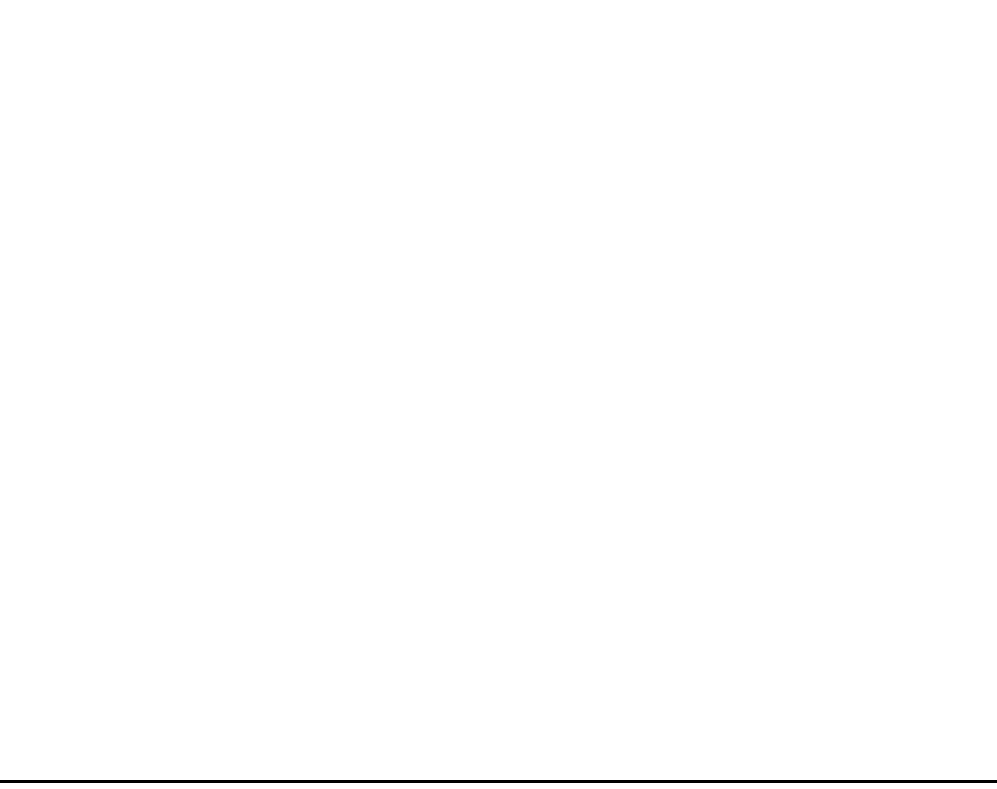
Figure 1 Part of the structure of (NH Hydrogen bonds are represented by dashed lines. [Symmetry codes: (i) 1 - x , 1- y , 2 - z ; (ii) x , 0.5 - y , 0.5 + z ; (iii) 2 - x , -0.5 + y , 1.5 - z ; (iv) 2 - x , - y , 2 - z ; (v) 2 - x , 0.5 + y , 1.5 - z